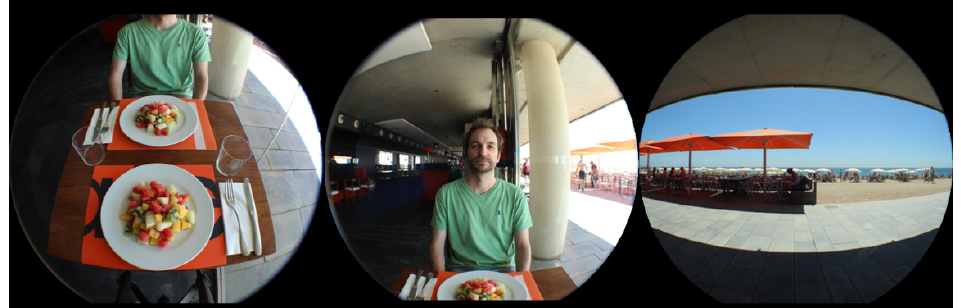
Figure 2. Real pictures of Sal Café restaurant with each workplane: table, a person in front and window. For each picture, the High Dynamic Range (HDR) of three exposures, − 2, 0 and 2, has been obtained and they are ISO 400 and 8.0 M 3456 × 2304 image quality (Canon EOS 600D, with Canon objective EFS 18–55 mm).